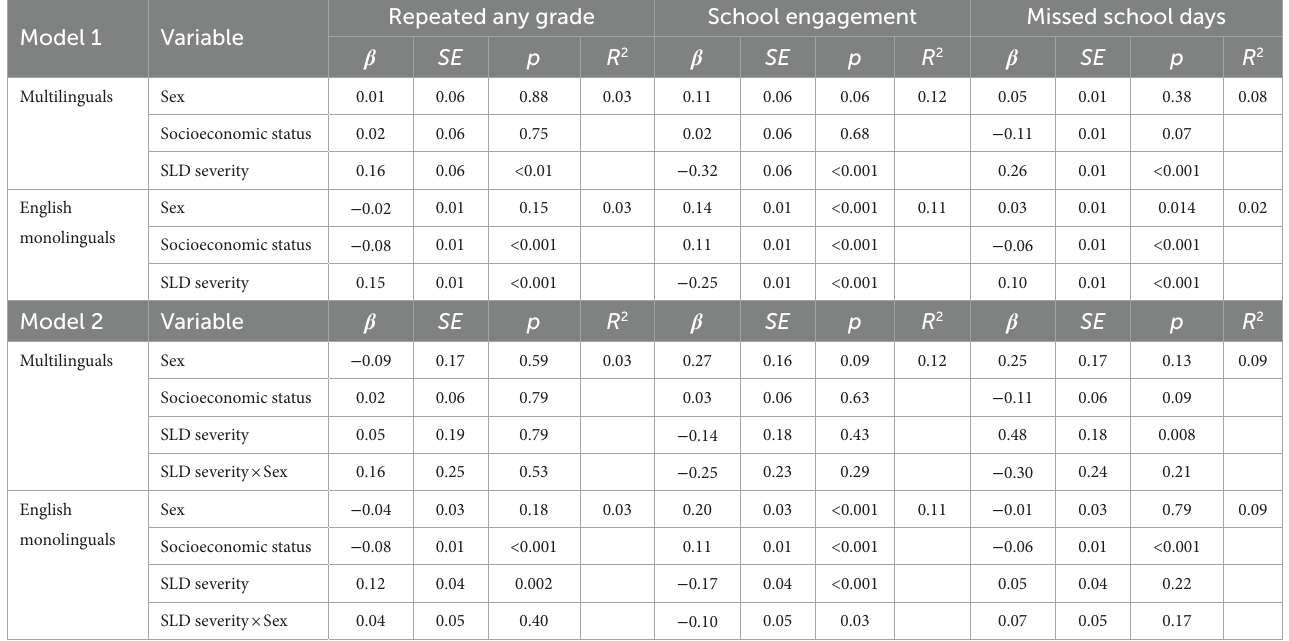
TABLE 6 Regression coefficients of academic success by sex, SES, and speech language disorder severity by group.